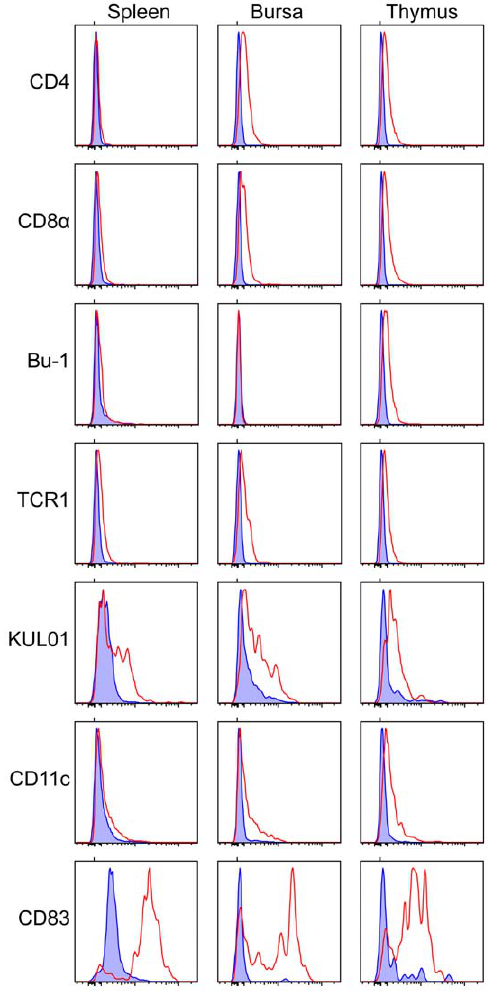
Figure 11. DEC205 expression on leucocyte subsets. Spleno- cytes, bursal cells and thymocytes recovered by enzymatic digestion were stained with DEC205 antibody and antibodies recognising each of the indicated antigens. The figure shows histograms of the DEC205 antibody fluorescence for cells gated for positive expression of the markers indicated at the left. Controls are the staining of appropriate subclass control antibodies on cells gated for the same markers.